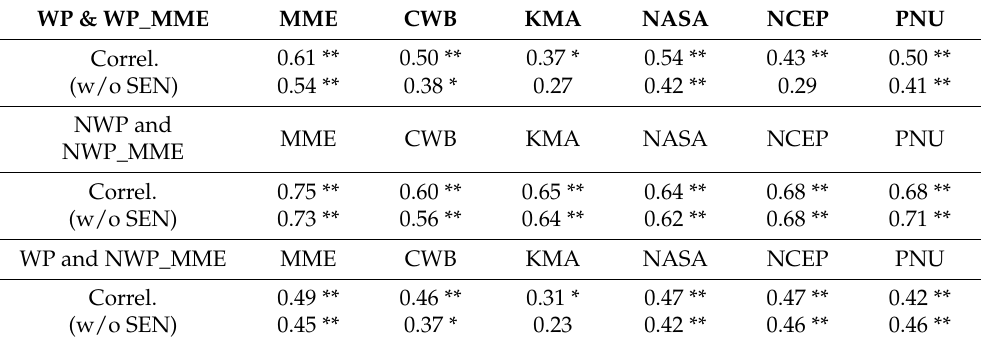
Table 4. Correlation coefficients between observed WP (NWP, WP) and predicted by MME and individual models WP (NWP, NWP). Significance at the 99% (95%) level is denoted with a double (single) asterisk.